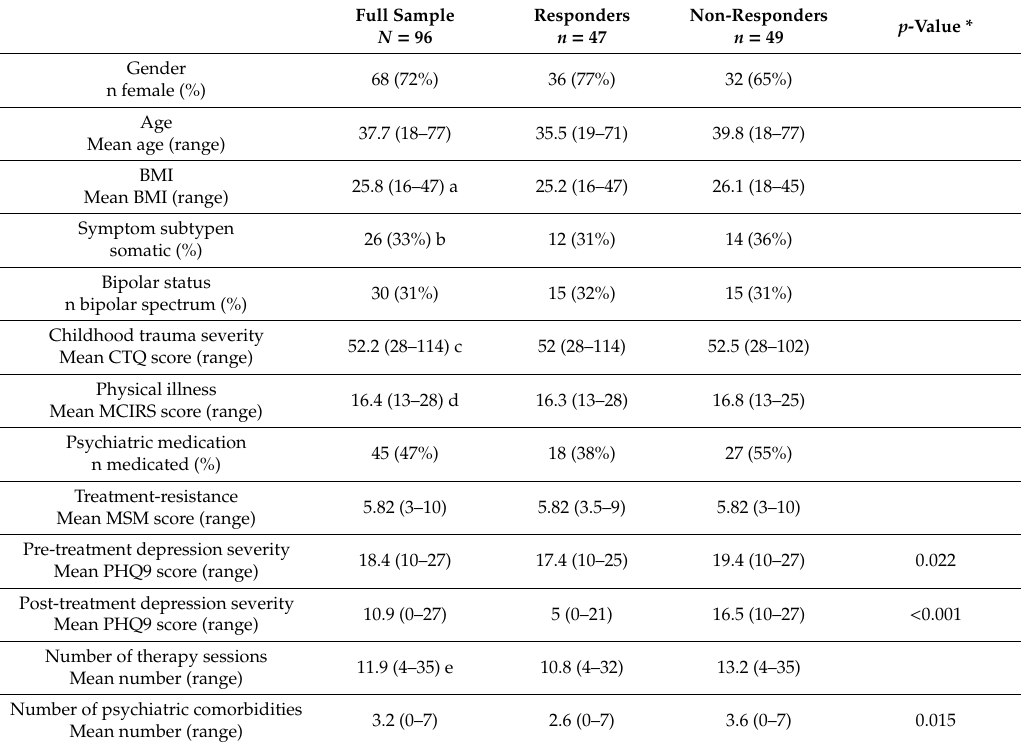
Table 1. Participant